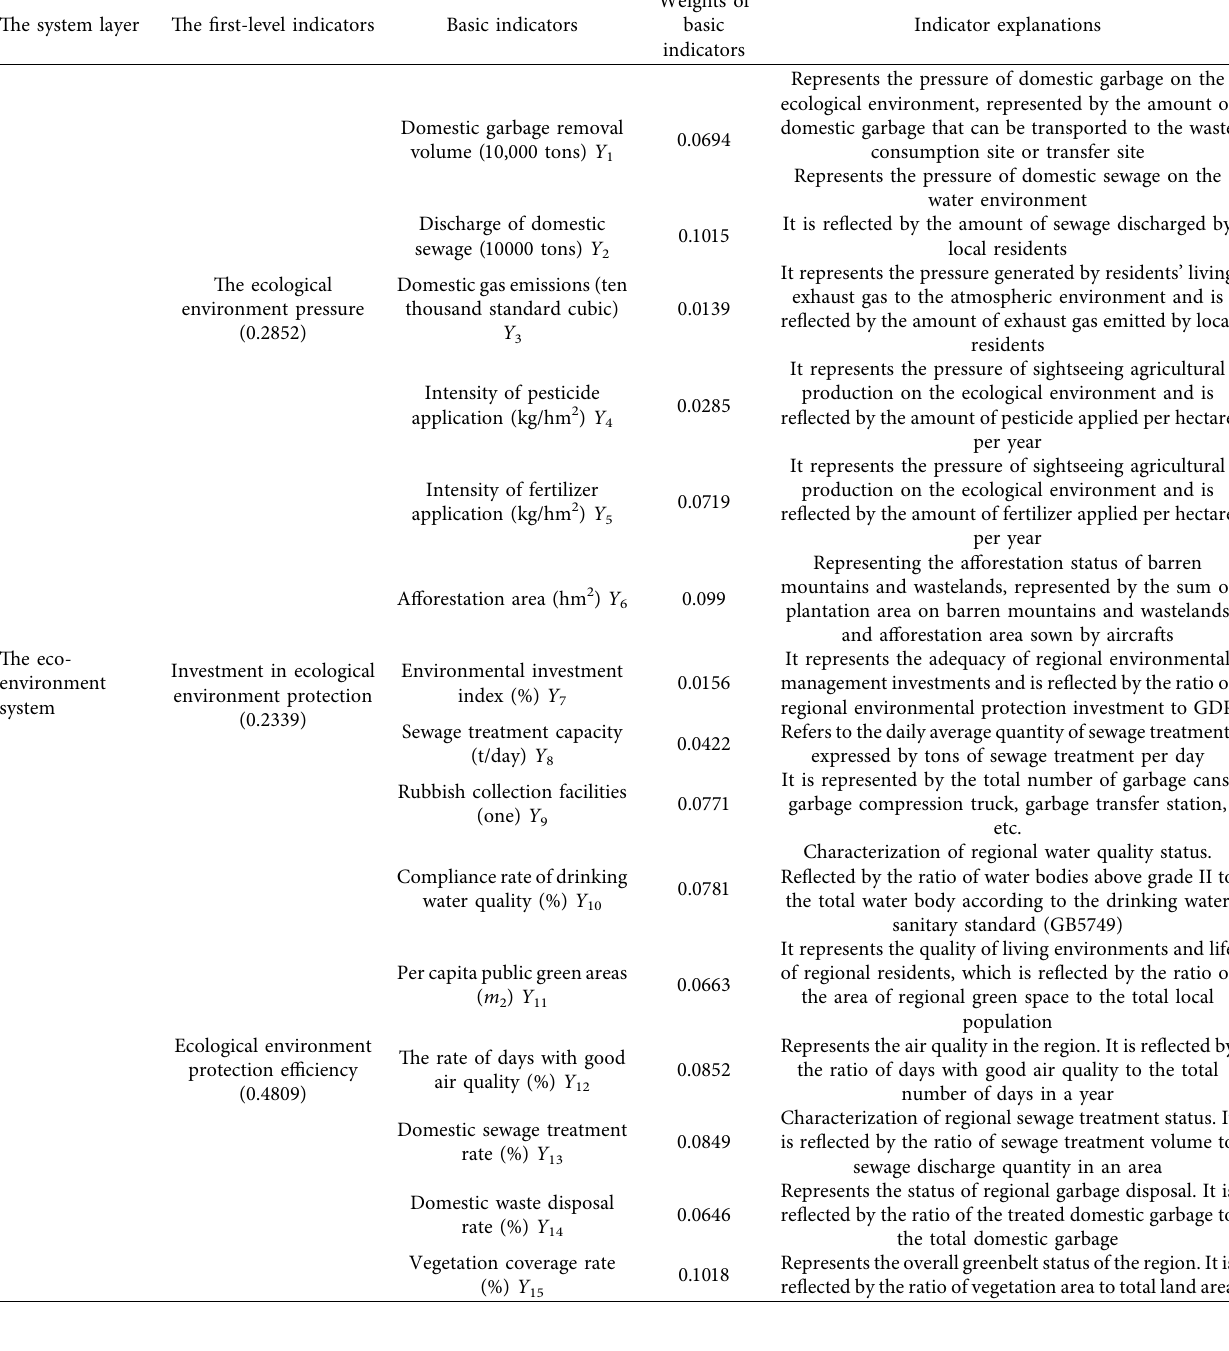
Table 2: The eco-environment system assessment indexes and meanings in poor mountainous